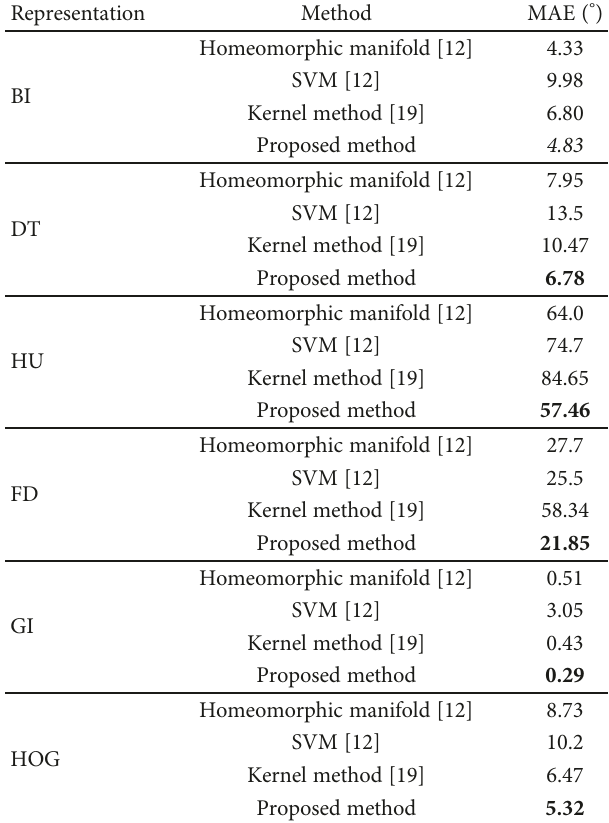
Table 7: Joint satellite recognition and pose estimation results on the 1D subset of BUAA-SID 1.5. Results are in bold if the proposed method performs the best and in italic if the second